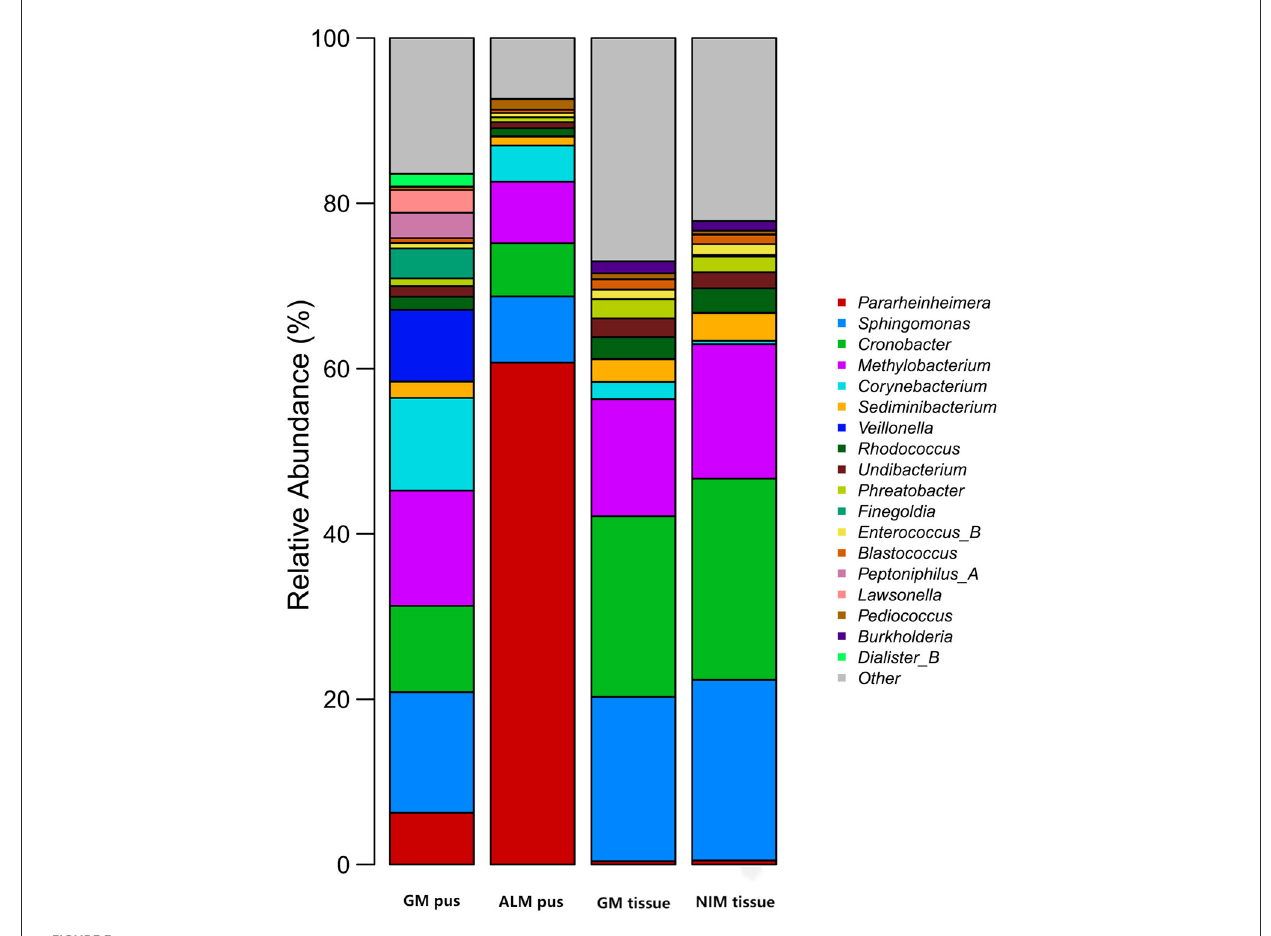
FIGURE3 Top 10 genera in four groups. A total of 18 genera were